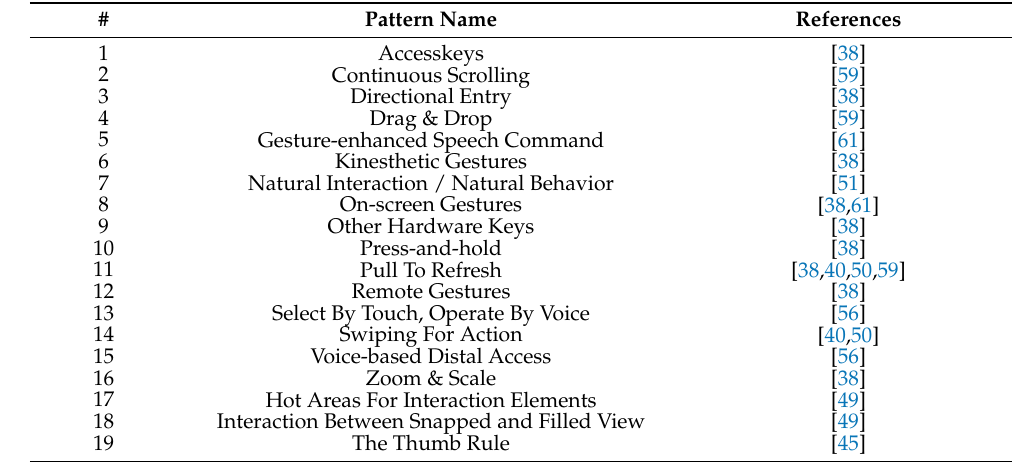
Table 17. Interactions